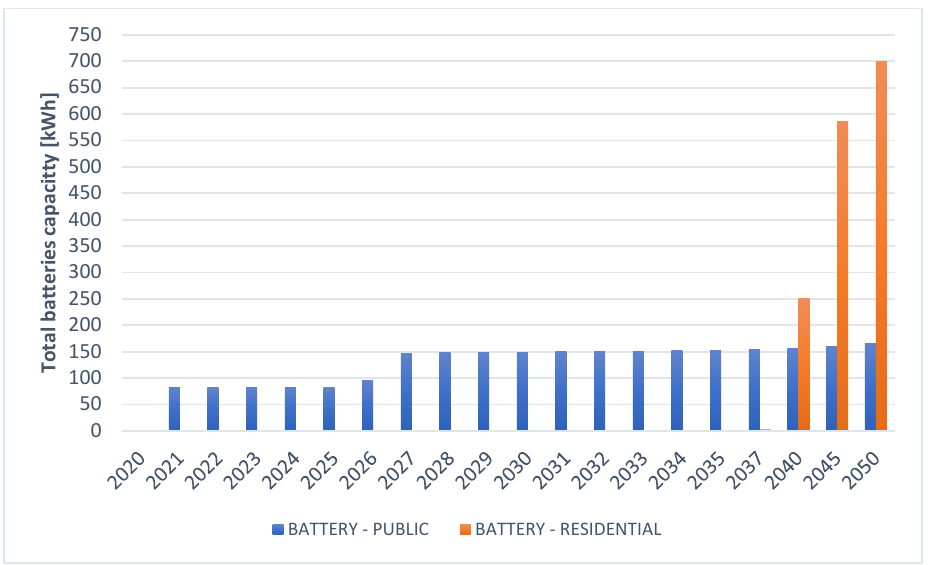
Figure 16. Battery capacity evolution over the time horizon ( HIGH_STG and HIGH_STG_EFF scenarios).